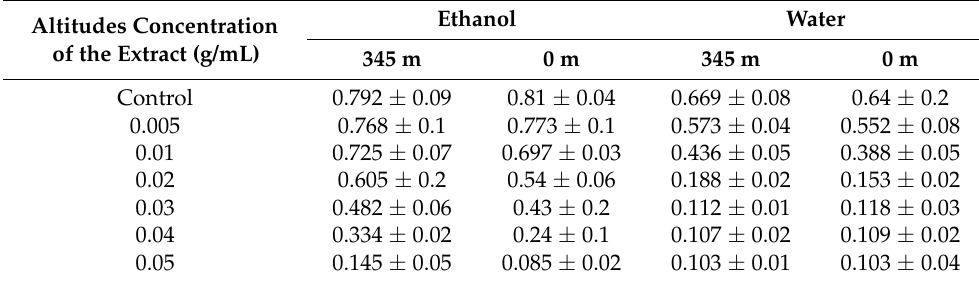
Table 6. DPPH absorbance of the different concentrations of ethanolic and aqueous